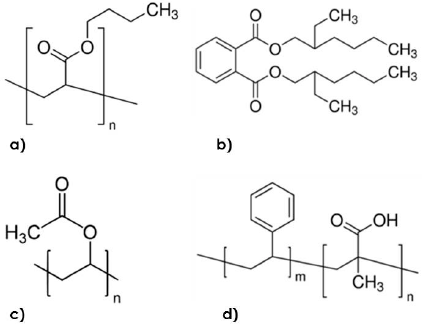
Figure 3. Compounds found in stickies by FTIR. ( a ) PBA; ( b ) dioctyl phthalate; ( c ) poly (vinyl-acetate); ( d ) poly (styrene-acrylate).